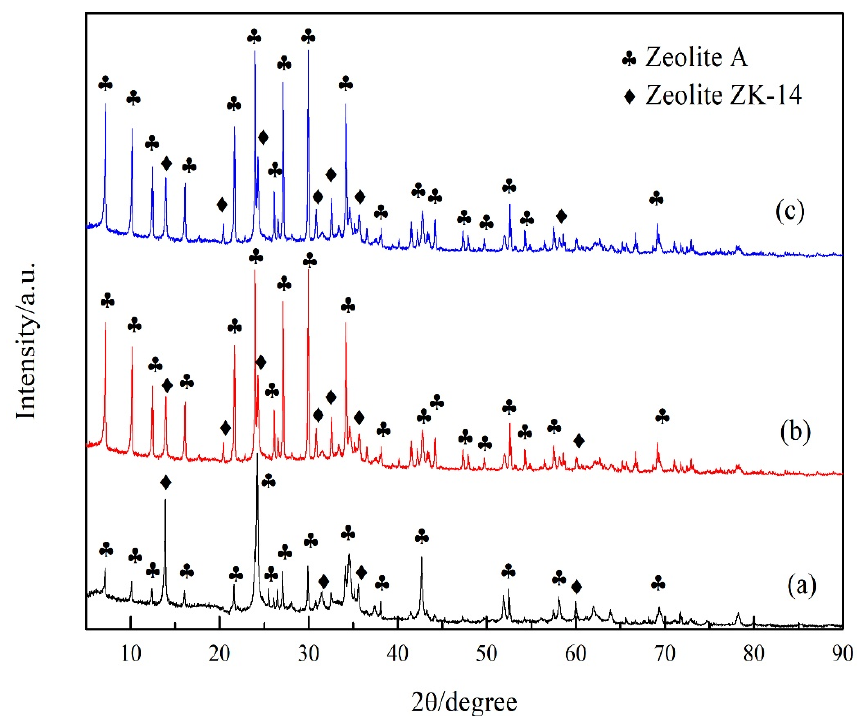
Figure 1. X-ray diffraction (XRD) patterns of the product samples obtained at crystallization time of ( a ) 4 h ( b ) 6 h and ( c ) 8 h.